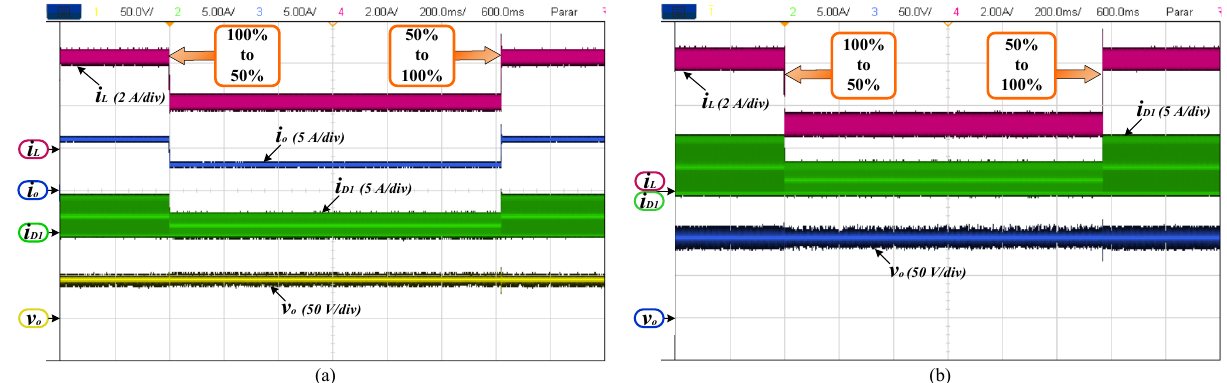
Figure 12. Dynamic responses of the converters (time: 200 ms/div): ( a ) 3SSC-A-based buck: v o (50 V/div); i D (5 A/div); i L (2 A/div); i o (5 A/div); ( b ) 3SSC-A-based buck-boost: v o (50 V/div); i D 1 (5 A/div); i L (2